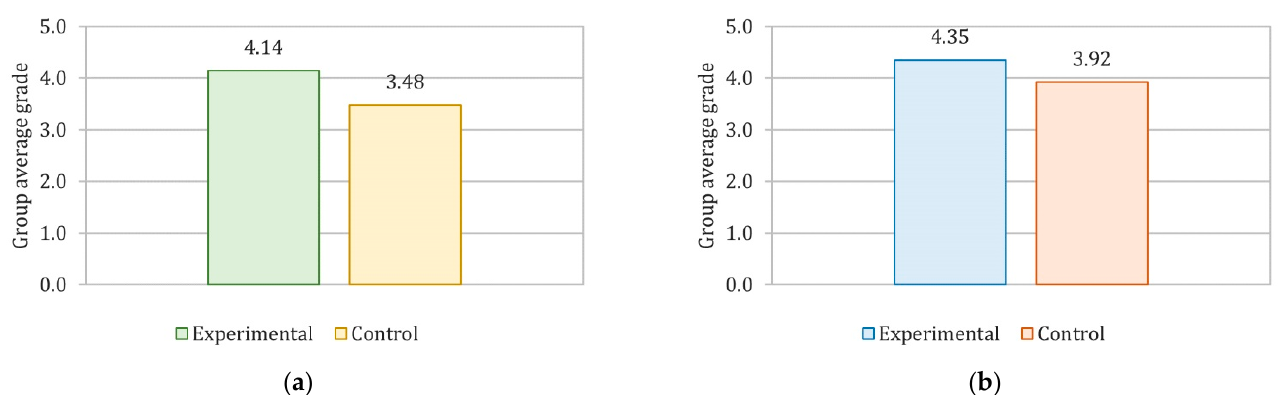
Figure 5. Post-test results. ( a ) Computer Programming; ( b ) Graphic Programming.